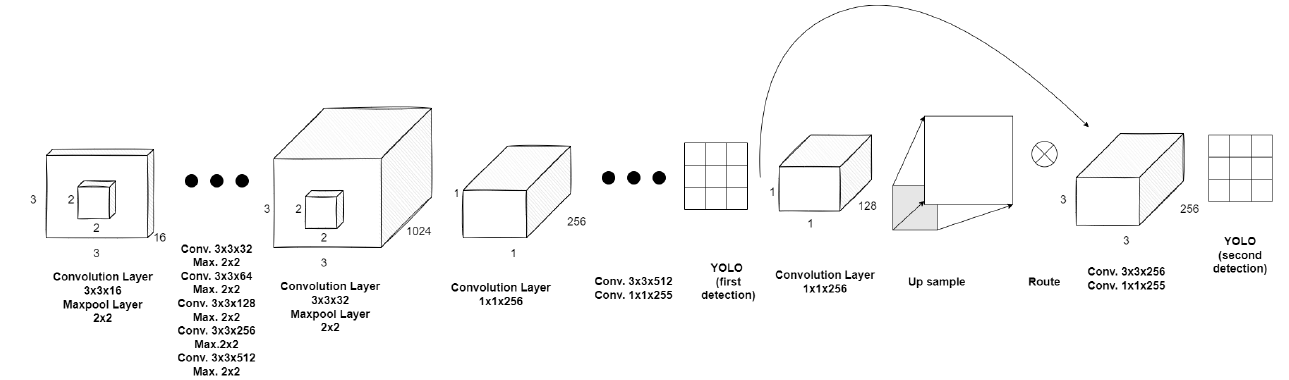
Figure 6. YOLOv3 tiny version network architecture